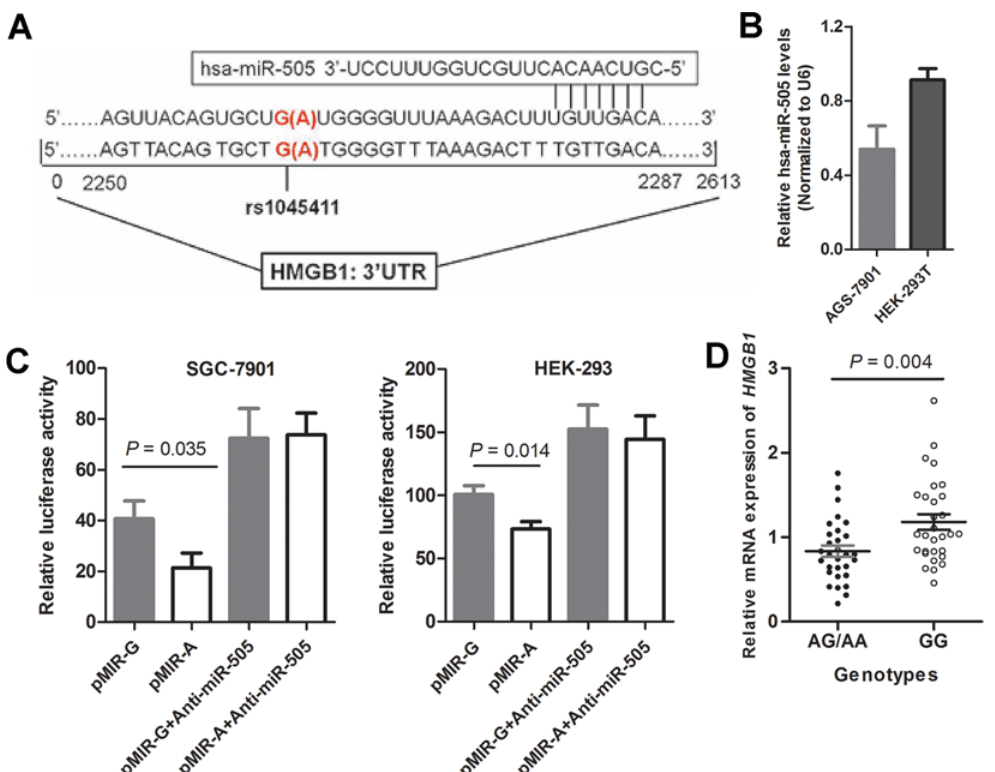
Fig 3. Functional effect of SNP rs1045411 genotypes on gene expression by luciferase reporter assay. (A) The sequence including SNP rs1045411 in 3 ’ UTR of HMGB1 gene. (B) Relative expression levels of hsa-miR-505 in SGC-7901 and HEK-293T cells. (C) The effect of SNP rs1045411 genotypes on the expression of HMGB1 gene in SGC-7901 and HEK-293T cells. (D) Relative mRNA expression level of HMGB1 gene in 60 GC tissues with different SNP rs1045411 genotypes. Recombinant vector (pMIR-rs1045411-G or pMIR- rs1045411-A) and pTL-TK were co-transfected into SGC-7901 and HEK-293T cells. Data are expressed as mean ± standard deviation (SD) of three independent experiments. Student ’ s t test was used to examine statistical difference.